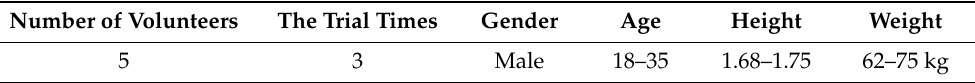
Table 4. The volunteer characteristics.